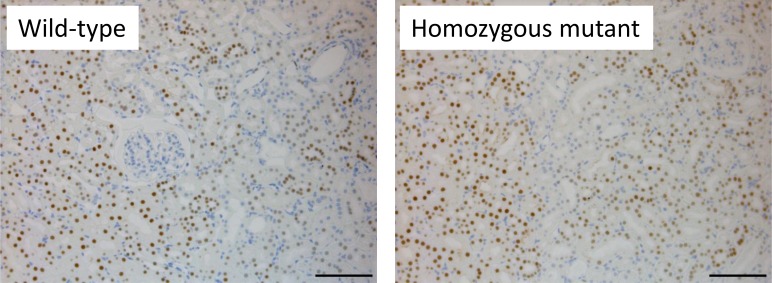
Immunohistochemical localization of POU3F3 in kidneys.POU3F3 was detected in nuclei of numerous but not all tubule segments with weak up to strong staining intensity in a wild-type kidney. The immunostaining pattern and staining intensity of POU3F3 in the kidney of a Pou3f3L423P homozygous mutant mouse was similar to the findings observed in the wild-type control kidney. DAB (brown color); nuclear staining: haemalum (blue color). Age of mice analyzed: 22 months. Bars represent 100 μm.